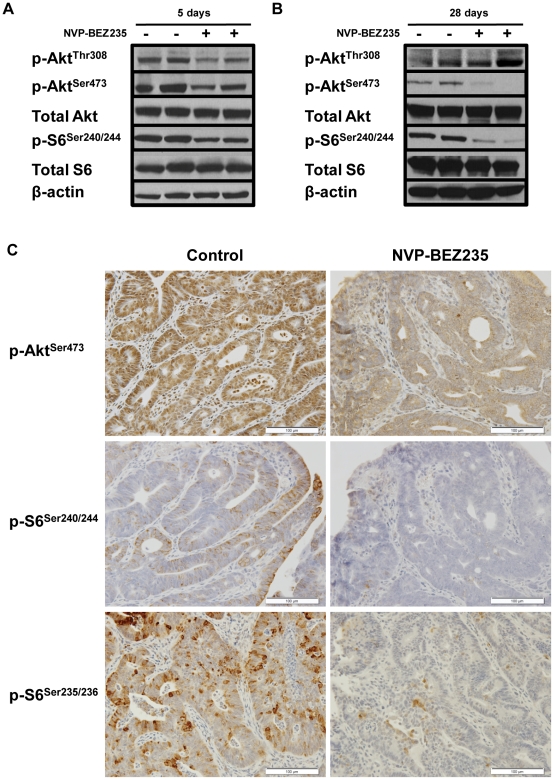

In vivo NVP-BEZ235 treatment of a GEM model for sporadic CRC results in transient PI3K blockade inhibition and sustained mTORC1/mTORC2 blockade.Mice with colonic tumors were randomized to treatment with control diluent or 45 mg/kg NVP-BEZ235 by daily oral gavage for five days. Western blot analysis of p-AKTThr308, p-AKTSer473, and p-S6Ser240/244 was performed for tumors treated with (−) control diluent or (+) NVP-BEZ235 for (A) five and (B) 28 days. (C) Immunohistochemistry of p-AKTSer473, p-S6Ser240/244, and p-S6Ser235/236 was performed for tumors treated with control diluent or NVP-BEZ235 for 28 days.